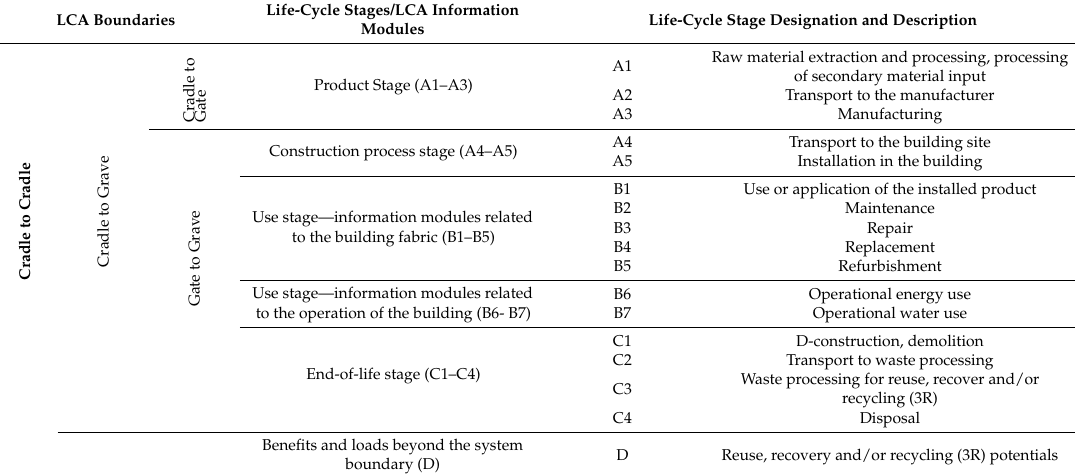
Table 3. Life-cycle stages of buildings and building materials based on European standards (CEN,